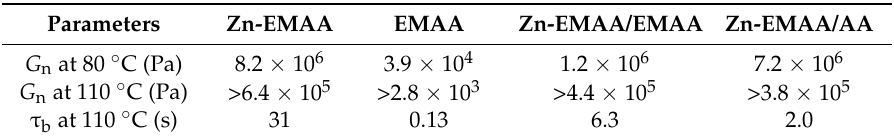
Figure 3. Frequency sweep experiment of the Zn-EMAA polymer at 80 and 110 °C. The supramolecular bond lifetime τ b is determined for both polymers at intersection of the G ’ and G ” at 110 °C. Table 1. Overview of the plateau moduli at different temperatures and the supramolecular bond lifetime at 110 °C for all polymer matrix blends.